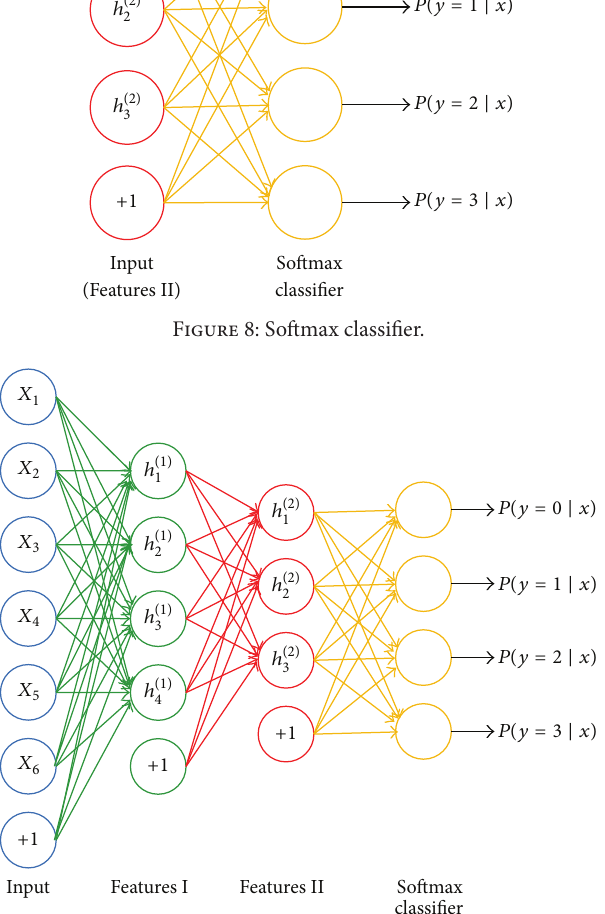
Figure 9: SAE with softmax